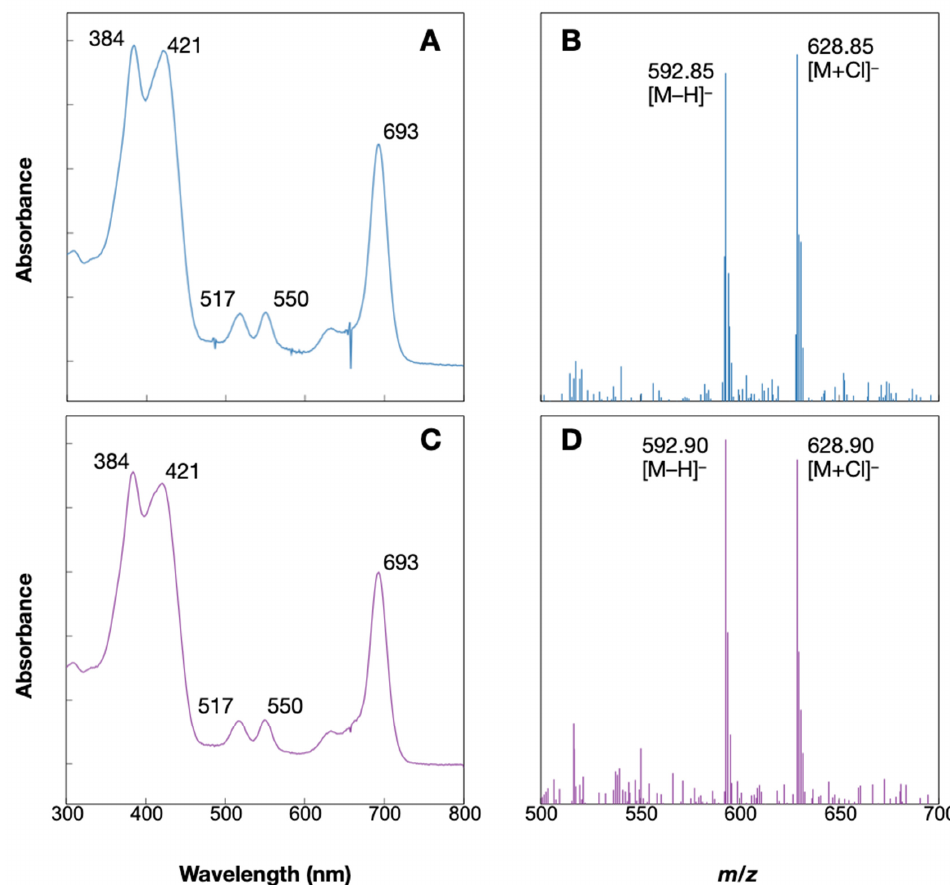
Figure 6. Identification of accumulated Chl d -like pigment. In-line absorption spectra ( A ) and mass spectra ( B ) of the 6.6 min elution peak in Figure 5A are shown. Panels ( C , D ) represent in-line absorption and mass spectra of the Pheide d standard, respectively.